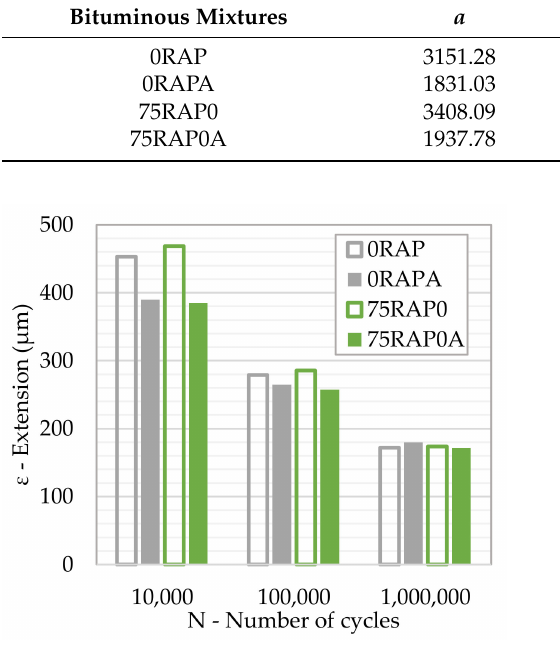
Figure 8. Extension to failure as a function of the number of loads 10 4 , 10 5 and 10 6